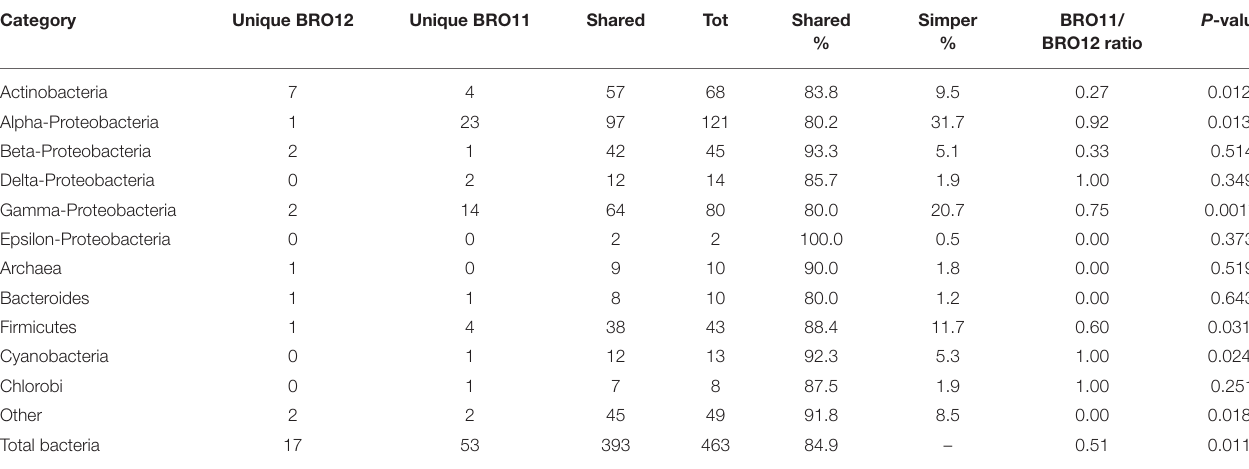
Simper BRO11/ % % BRO12 ratio